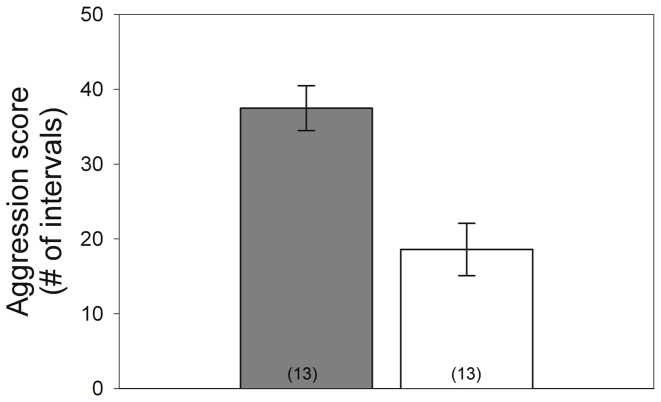
Aggression.Testosterone-implanted females (shaded bar) were significantly more aggressive than control females (open bar). Sample sizes are shown in parentheses; error bars represent the standard error of the mean.